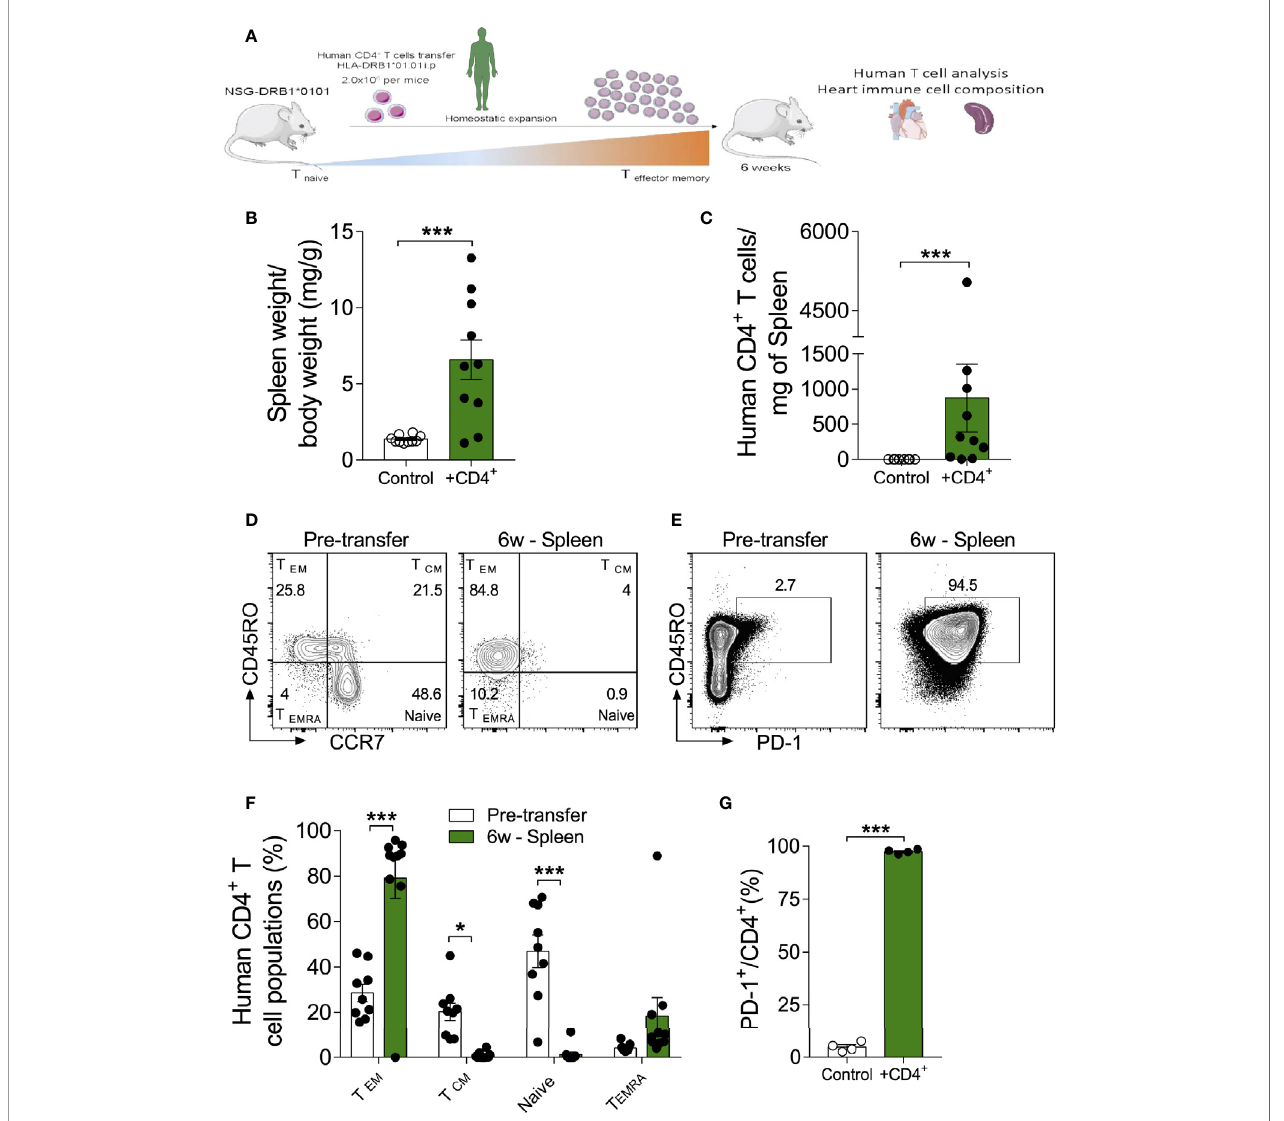
FIGURE 2 | The xenograft transplantation model renders young mice harboring a senescent-like T-cell compartment. (A) Experimental design: Immunode fi cient NSG-DR1 mice were adoptively transferred with CD4 + T cells puri fi ed from matching human donors, which readily undergo homeostatic expansion without causing xenograft reactions. Naïve NSG-DR1 mice were used as controls. Six weeks after transfer, heart and spleen tissue were collected for analysis. (B) Spleen weight to body weight ratio and number of CD4 + T cells per milligram of spleen (C) depict the T cell engraftment of NSG-DR1 mice after 6 weeks. (D) Flow cytometry plots illustrate the frequency of naïve (CCR7 + CD45RO - ) and effector memory (CCR7 - CD45RO + ) CD4 + T cells before transfer and in NSG-DR1 spleen 6 weeks afterwards. (E) FACS plots also illustrate the distribution PD-1 + T cells before and after transfer in the spleen. Control group: Naïve NSG-DR1 mice. CD4 + group: NSG-DR1 mice transplanted with human CD4 + T cells. (F) Bar graph shows the shift from naïve toward an effector memory phenotype following 6 weeks of engraftment in the spleen. (G) Increased frequency of human PD-1 + T cells in the spleen of NSG-DR1 mice. The bar graphs display the group mean values (bar), the SEM and the distribution of each individual value. Statistical analysis in (B, C, G) : two-tailed paired t test, *** P < 0.001, in (F) : two-way ANOVA followed by multiple t tests, *** P < 0.001 and * P <